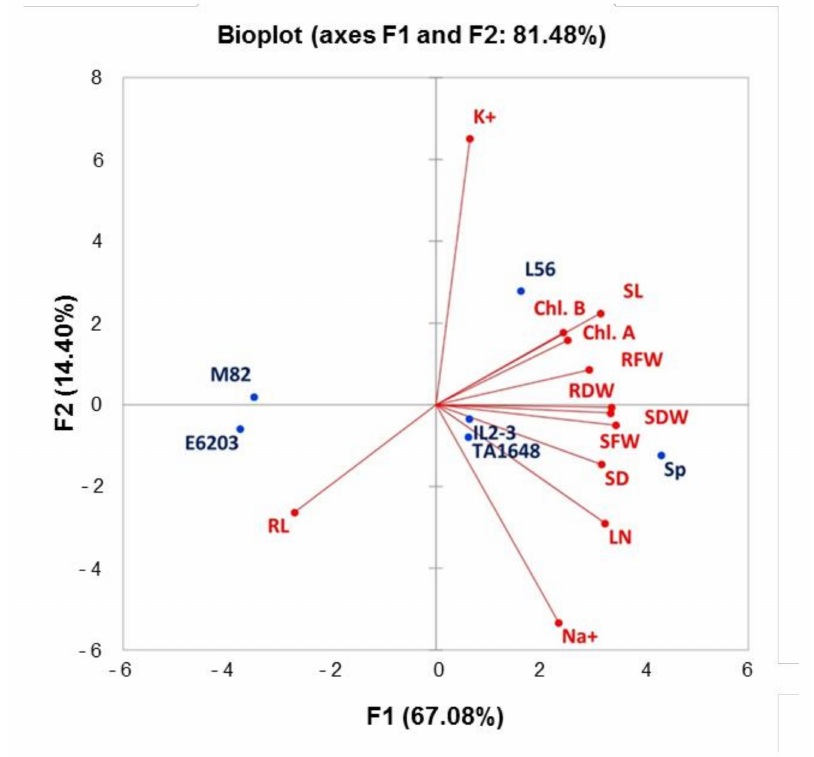
Figure 6. Principal components biplot (PC1 and PC2) for a salt tolerance index of 12 measured traits for six tomato genotypes grown under saline condition (120 mM). Leaf number (LN), shoot length (SL), stem diameter (SD), shoot fresh weight (SFW), shoot dry weight (SDW), root length (RL), root fresh weight (RFW), root dry weight (RDW), chlorophyll a (Chl.a), chlorophyll b (Chl.b), sodium leaf concentration (Na + ), and potassium leaf concentration (K +